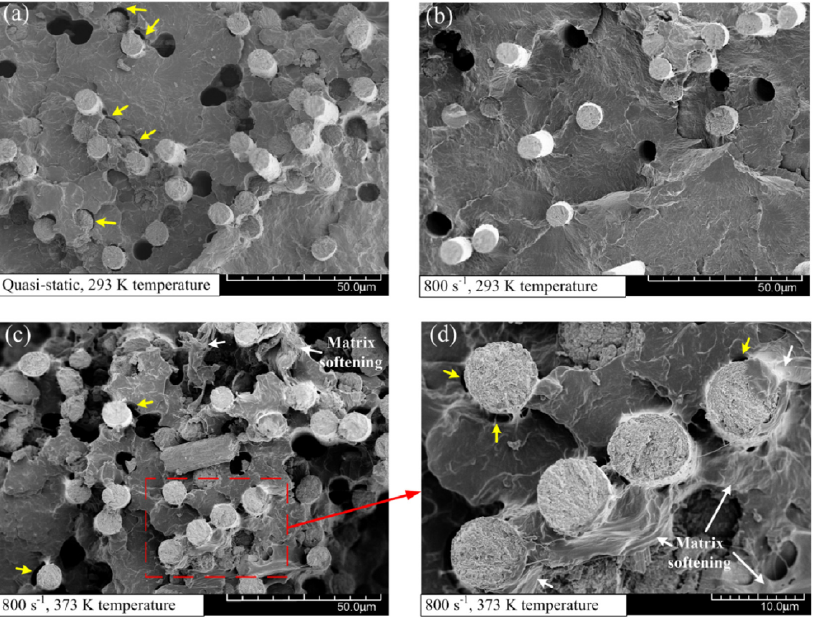
Figure 20. SEM micrographs of the fracture surface in layer at ( a ) quasi-static and 293 K temperature; ( b ) 800 s and 293 K temperature; ( c ) 800 and 373 K temperature and ( d ) its local enlargement view